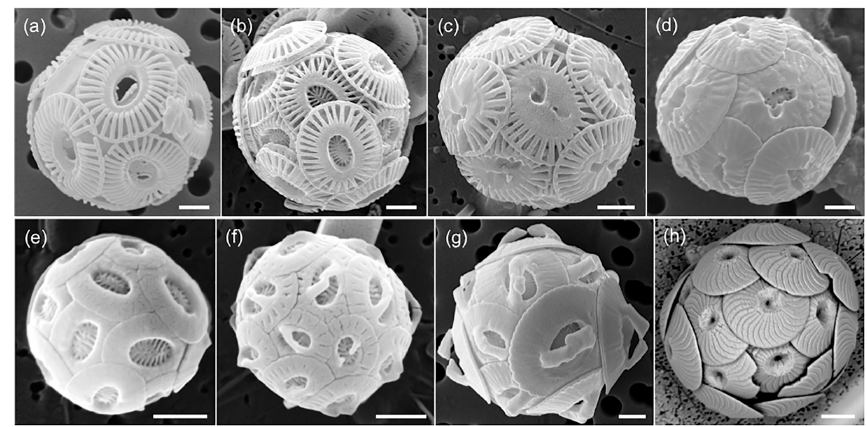
Figure 2. The most abundant coccolithophores in the SE Pacific. (a–d) Morphotypes of E. huxleyi : lightly calcified (a) , moderately calcified A morphotype (b) , morphotype A_CC (c) , morphotype R/over-calcified (d) . Gephyrocapsa parvula (e) , G. ericsonii (f) , G. muellerae (g)